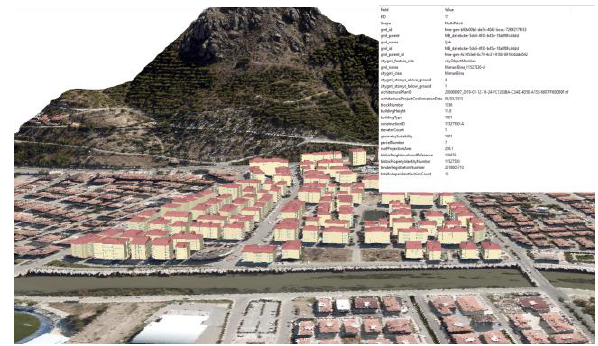
Figure 11. Example of 3D Geodatabase Various queries can be made on 3D geodatabase model and